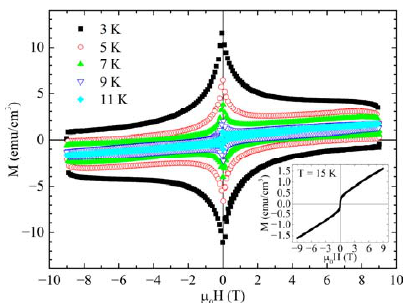
Figure 2. Superconducting hysteresis loops at different temperatures. Inset: magnetic hysteresis loop at T = 15 K. At this point, the critical current density as a function of the magnetic field J c (H) was extracted at different temperatures by using the Bean critical state model [49,50]: 20∆M J (cid:2913) = c (1) (cid:4674)c(cid:4672)1 − 3b(cid:4673)(cid:4675) where Δ M = M dn − M up is the difference between the magnetization measured for decreas- ing (M dn ) and increasing (M up ) applied fields, respectively. b (cm) and c (cm) are the length and width of the cross section of the crystal perpendicular to the applied field. The ob- tained J c (H) curves are reported in Figure 3. Observing the curves in the main panel and in the inset of Figure 3, it can be noted that a second magnetization peak phenomenon appears for T ≤ 7 K which is not visible at first sight when looking at the M(H) curves. In general, the J c (H) curves have a field decrease that prevents determining the irreversibility field H irr (evaluated as J c ≈ 100 A/cm 2 ) even for the highest temperature shown in Figure 3 (11 K) and at 9 T. Figure 3. Critical current densities as a function of field at different temperatures. Inset: a magnifi- cation of the curves near the region of the second magnetization peak phenomenon is shown. In order to deeply study the J c (H) anomalous behavior reported in Figure 3, the J c curves as a function of temperature J c (T) at different fields were extracted from the J c (H). In particular, by fitting the J c (T) behavior with several pinning models reported in the literature [51–57], it is possible to determine the pinning regime acting in the sample. Among the pinning models, the three equations that best fit our experimental data across the field range are the following ones: